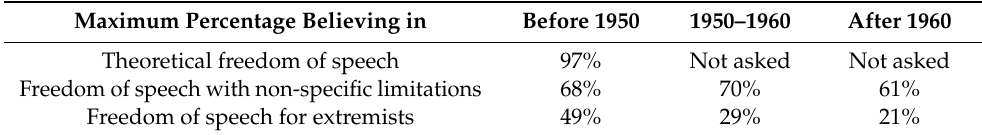
Table 1. Support for freedom of speech 1938–1970, from Erskine (1970). Maximum Percentage Believing in Before